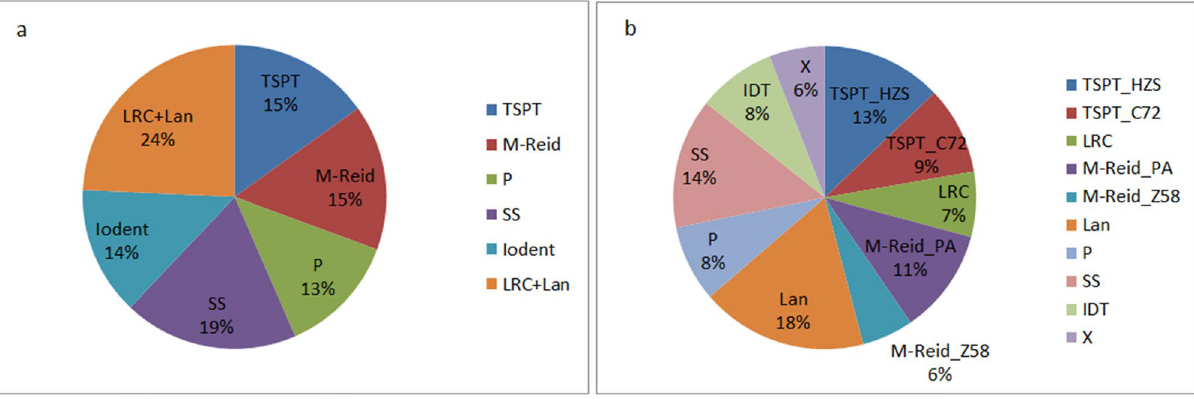
Figure 8. Heterotic groups of 490 inbred lines in CSM region. ( a ) K = 6; ( b ) K =